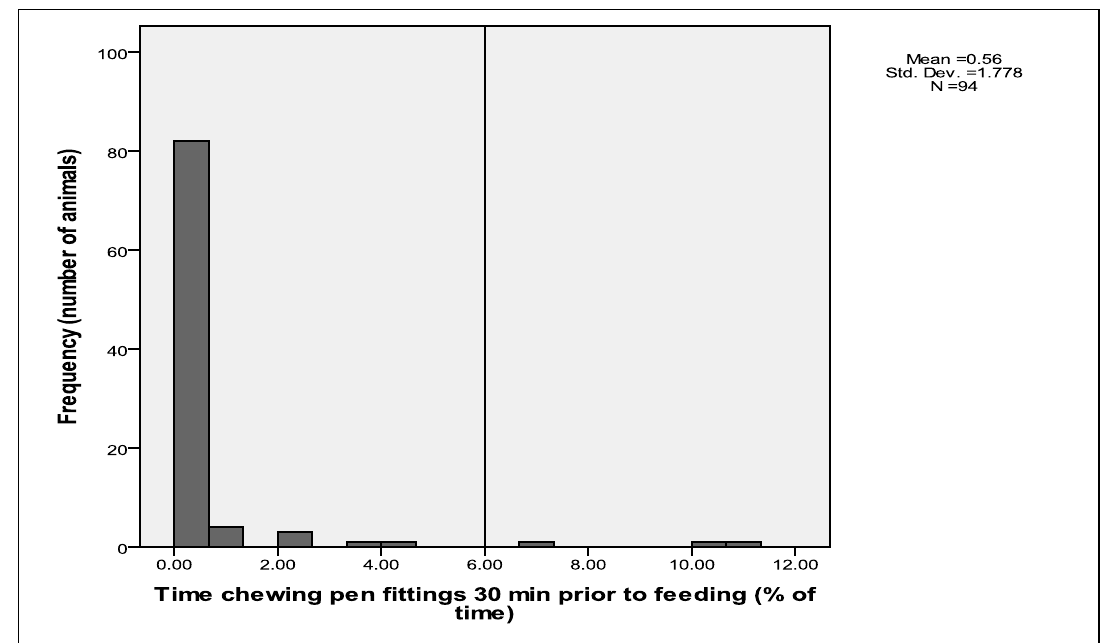
Figure 4. Histogram showing the distribution of time that sheep spent chewing pen fixtures in the 30 min prior to